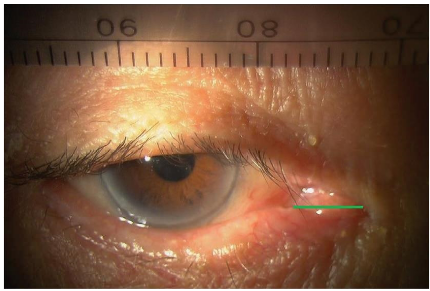
Figure 1: Measurement of the horizontal position of the lower lacrimal punctum. After exposure of the lower punctum, the horizontal distance from the medial margin of the lower lacrimal punctum to the medial canthus (green solid line) was